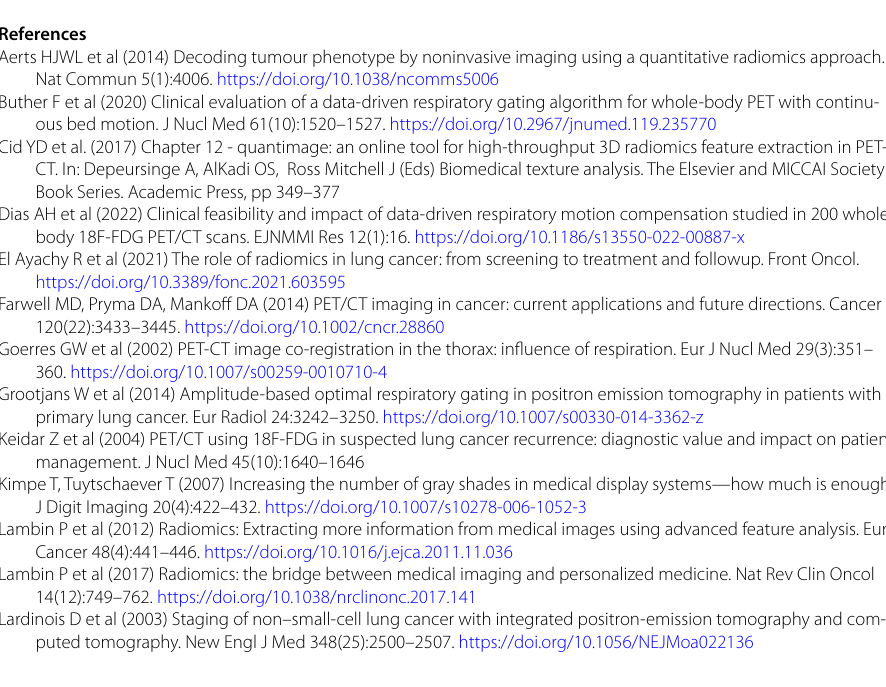
Table S3: Differences and concordance among free-breathing and data-driven gating PET/CT for all radiomics features calculated separately based on pulmonary lesions localisation. Table S4: Differences and concordance among free- breathing and data-driven gating PET/CT for all radiomics features calculated separately based on pulmonary lesions size.